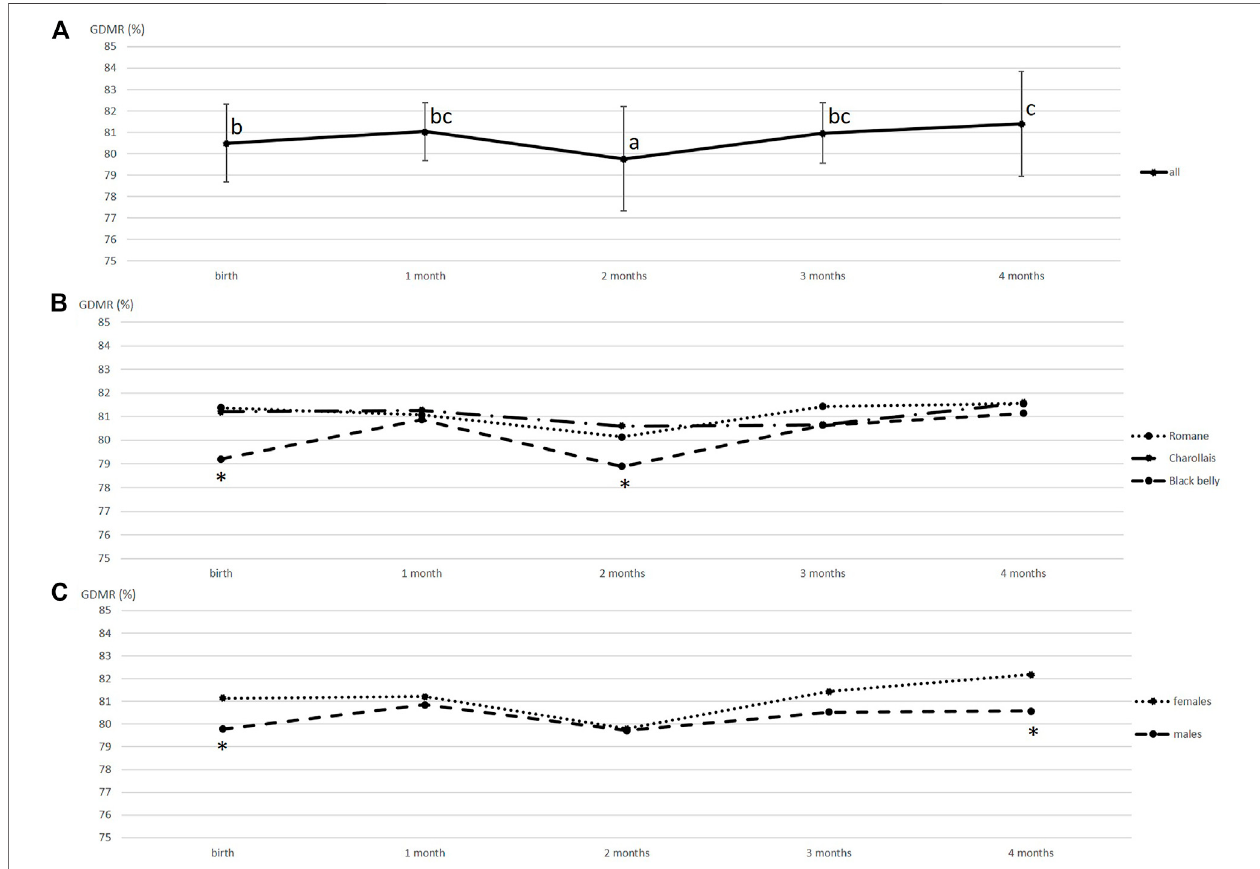
FIGURE 1 | Variations in the global methylation rate of blood DNA over time. (A) GDMR means were calculated for 59 animals, vertical bars represent standard deviation, values with different superscripts (a, b and c) were found to differ signi fi cantly ( p < 0.05). (B) GDMR means were calculated for each breed, Charollais ( n = 12), Romane( n =24)and Blackbelly( n =23).Foreach date,asterisksindicate thattheBlackbellyvaluedifferssigni fi cantly( p < 0.05). (C) GDMR meanscalculatedaccording to sex, 28 males and 31 females. For each date, asterisks indicate that the male and female values differ signi fi cantly ( p <